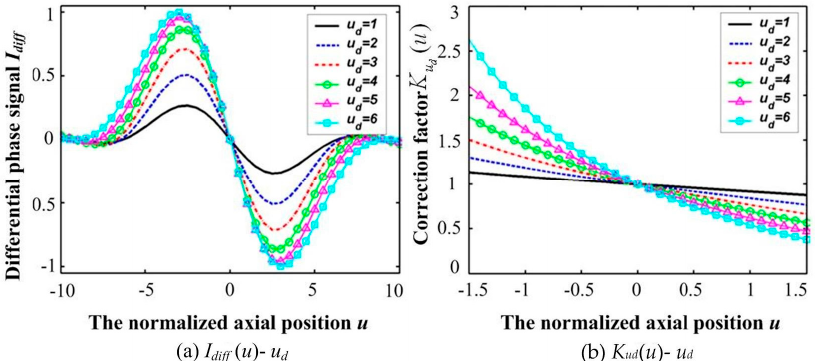
Figure 3. Variations in I diff ( u ) and K ( u d ) responding to various defocused quantities u d .